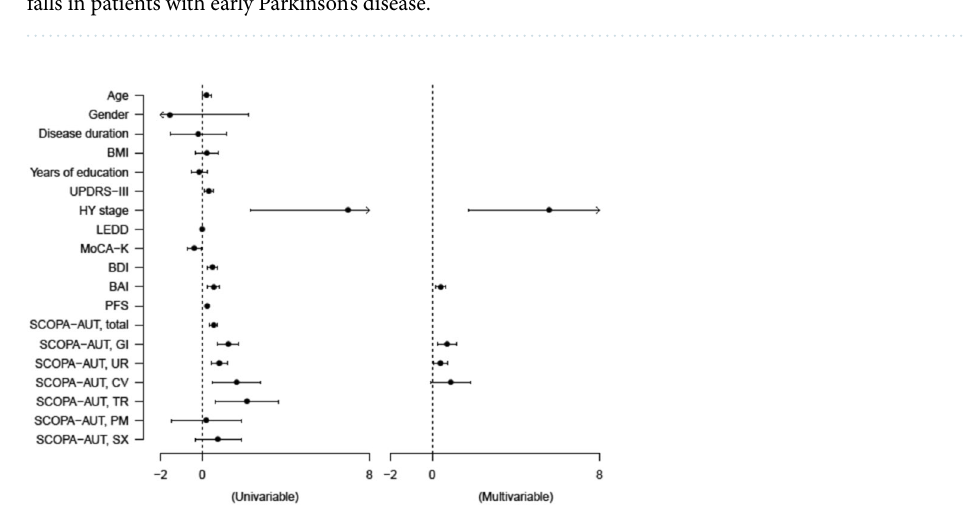
Figure 2. Forest plots showing the linear regression analyses of clinical characteristics for the fear of falling in patients with early Parkinson’s disease.